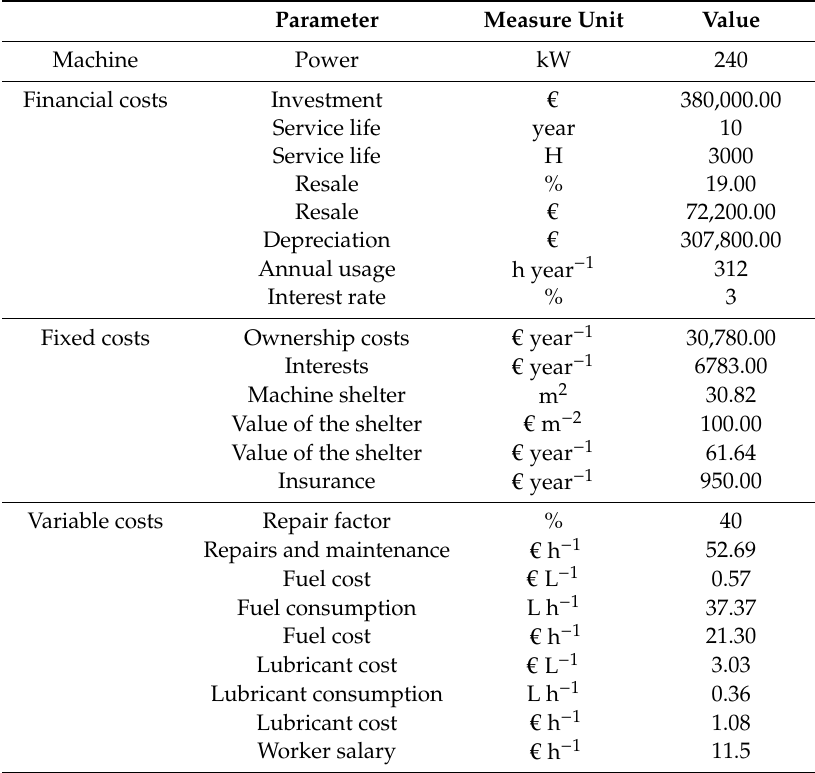
Table 2. Parameters for cost